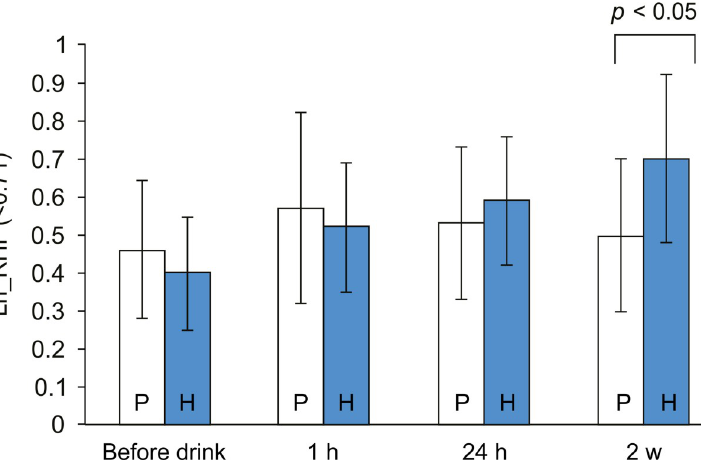
Fig 3. Ln_RHI values for the low Ln_RHI group (Ln_RHI < 0.7). Results are presented as the height of the columns at each time point. P: the placebo group, H: the high H 2 group. Error bars are indicated on each column, and p -values are indicated above the compared columns between the two groups. RHI: reactive hyperemia index, H 2 : hydrogen. https://doi.org/10.1371/journal.pone.0233484.g003 Ln_RHI value of 0.618 in 92 participants with atrial fibrillation undergoing catheter ablation [26]. Orthopedic patients who underwent total hip or knee arthroplasty and avoided postoper- ative deep vein thrombosis (DVT) had preoperative ln-RHI values of 0.71 ± 0.25 [27]. Among these reports, the border value of 0.71 for the orthopedic patients avoiding DVT seems to be close to that of the healthy masses. To predict future endothelial health in healthy subjects in this study, it seemed to be appropriate to set the threshold for RHI above the values for patients with cardiovascular risks. We set the Ln_RHI value at 0.71 in order to divide the subjects into two groups. In the low Ln_RHI group, the continuous consumption of H for 2 weeks significantly 2 improved the Ln_RHI value compared to placebo. An unexpected result that we found was that there was no improvement at 24 h after the first drink. To account for this result, both the time at 1 h and at 24 h after the single drink, showed significant improvement from the values before ingestion of the drink were also observed within the placebo group (Table 3). Because